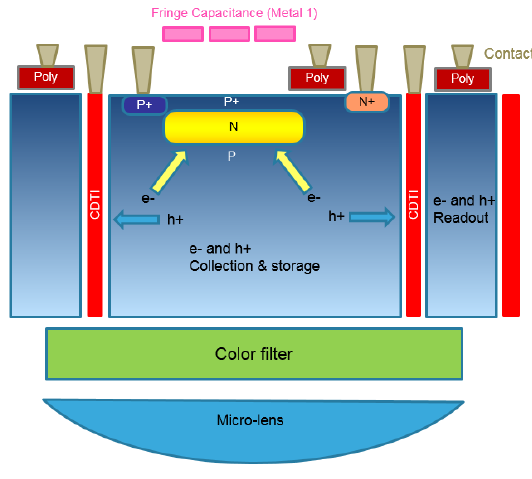
Figure 2. Schematic cross-section of the pixel.